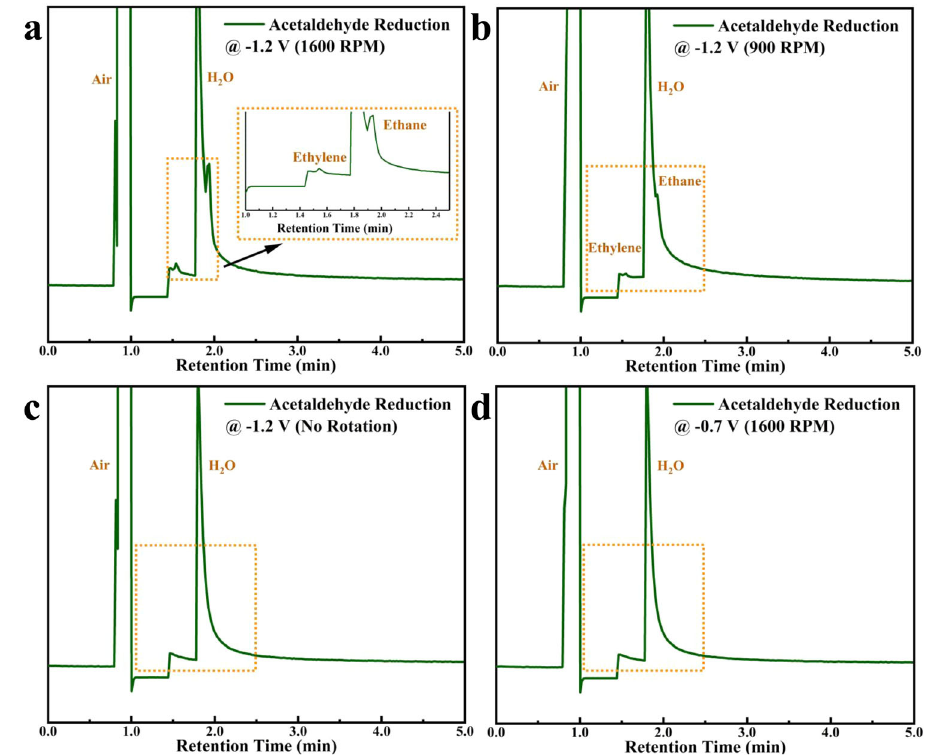
Fig. 2 | Combined rotating disk electrode with gas chromatography-mass spectrometry measurements for detecting gaseous products generated from the electroreduction of acetaldehyde. Gas products were auto-injected via a gas sampling mechanism and analyzed using GC-MS in selected ion monitoring (SIM)